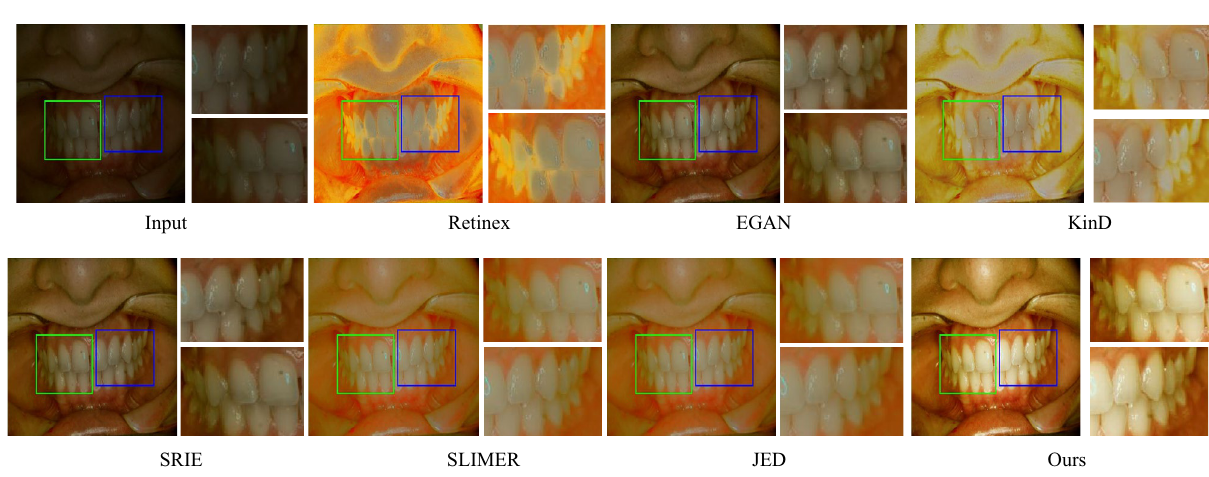
Figure 11. Comparison of the proposed method (ours) with several state-of-the-art